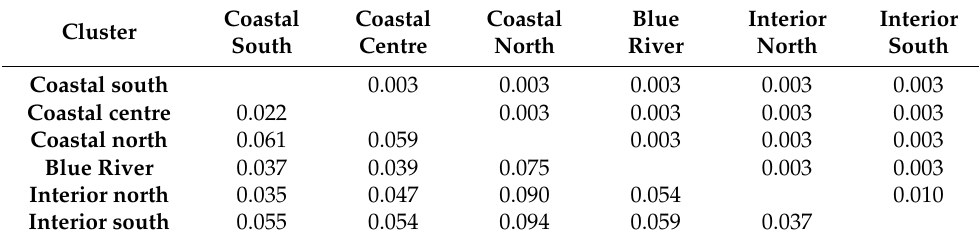
Table 3. Pairwise F ST values (below diagonal) between clusters for the K = 6 clustering solution (according to the STRUCTURE analysis) and probability of random F ST value being higher than